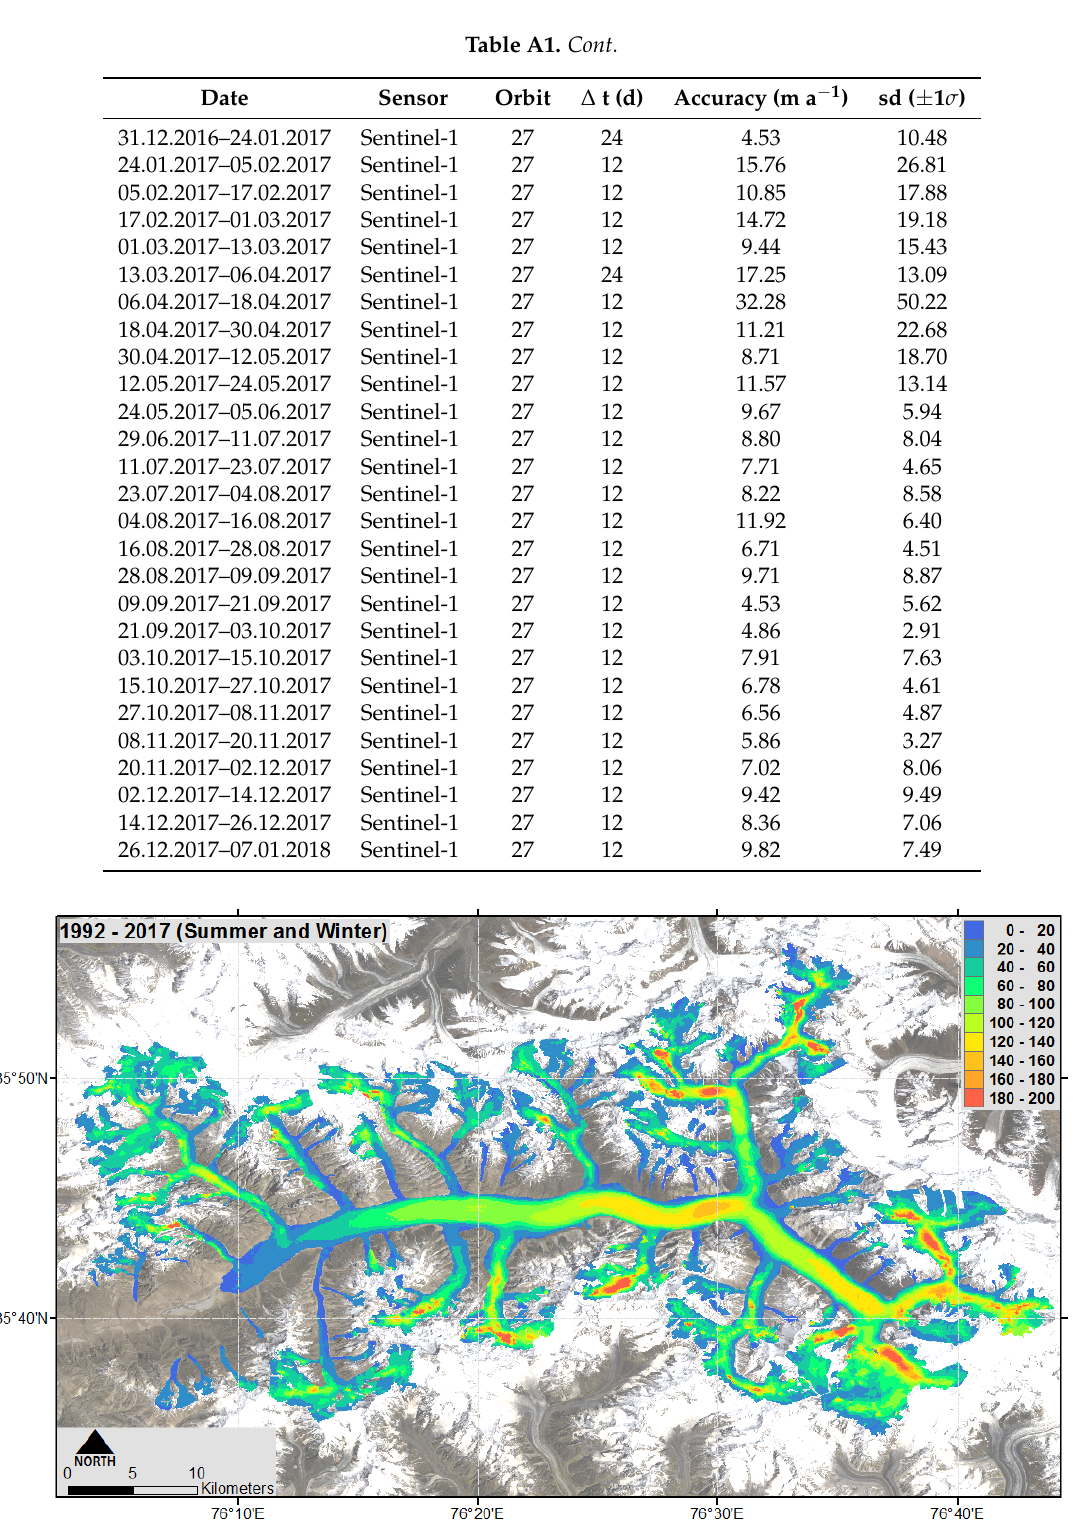
Figure A2. Averaged velocity field of all summer and winter surface velocities (m a − 1 ) for the period 1992 to